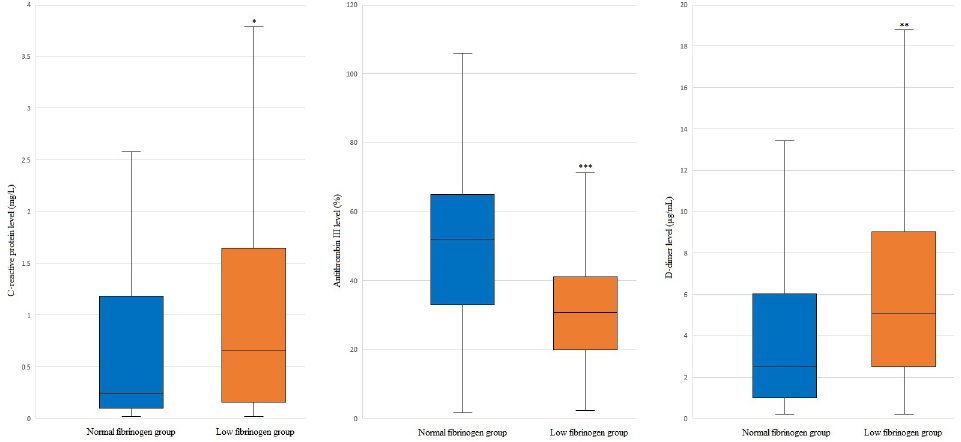
Fig 3. Comparison of preoperative findings between patients in the low and normal fibrinogen groups who underwent living donor liver transplantation (LDLT). The box plots show the median (line in the middle of the box), interquartile range (box), and 5 th and 95 th percentiles (whiskers). � p = 0.004 vs. normal fibrinogen, �� p = 0.001 vs. normal fibrinogen, ��� p < 0.001 vs. normal